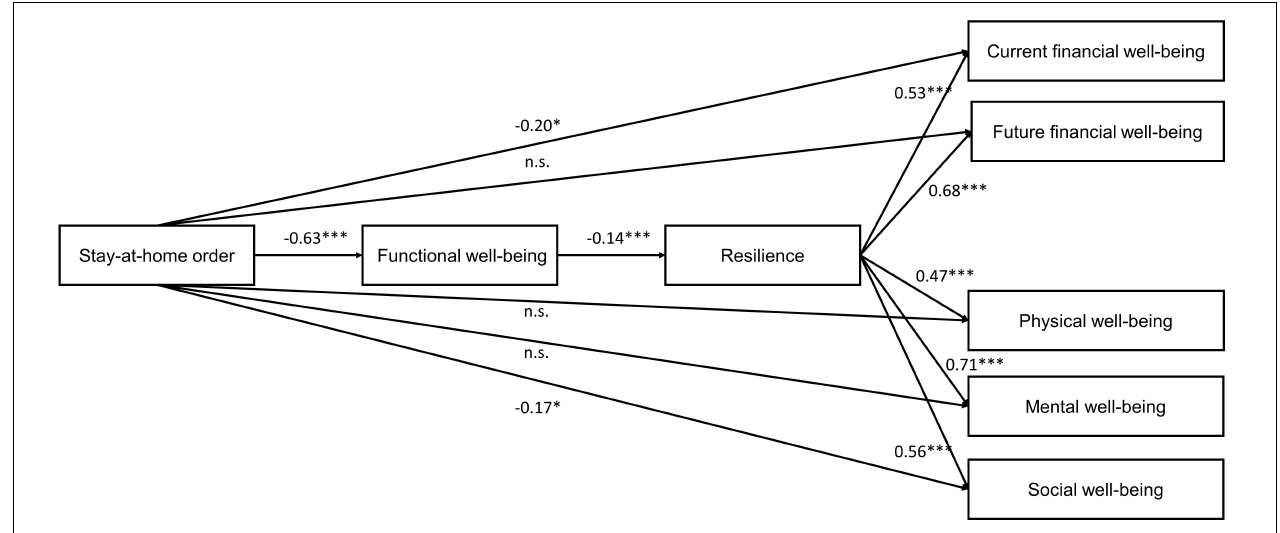
FIGURE 3 | Path coefficients for revised